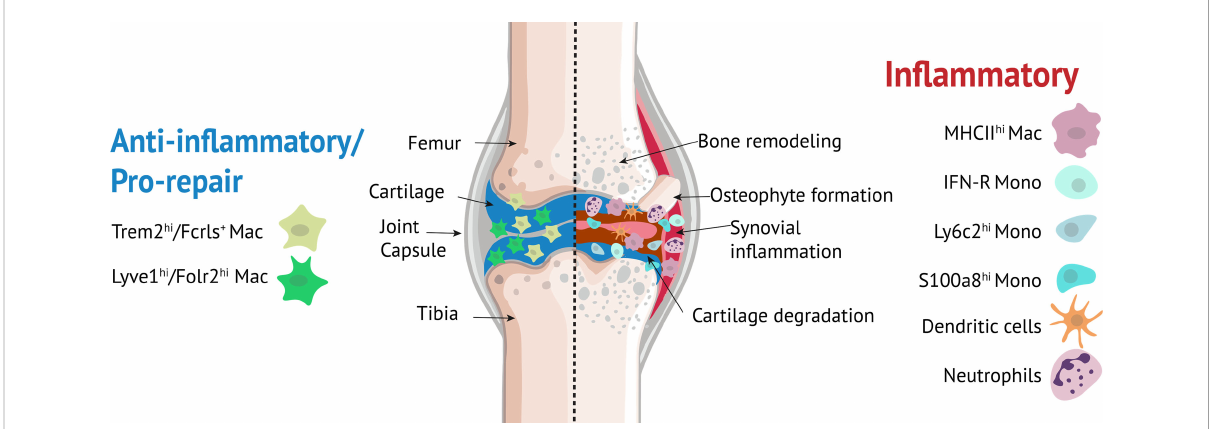
FIGURE 9 Myeloid cells in the knee joint. Lyve1 hi Folr2 hi and Trem2 hi Fcrls + macrophages play an anti-in fl ammatory/pro-repair role while monocytes, moDCs, MHC II hi macrophages and neutrophils may have pro-in fl ammatory